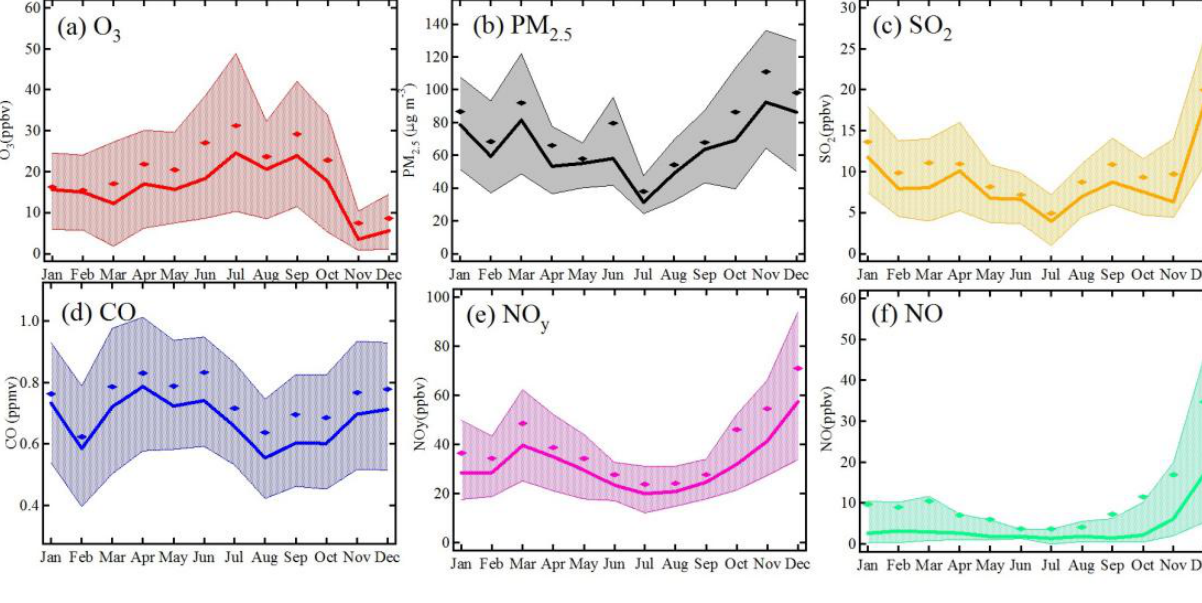
, ( b ) PM , ( c ) SO , ( d ) CO, ( e ) NO 3 2.5 2